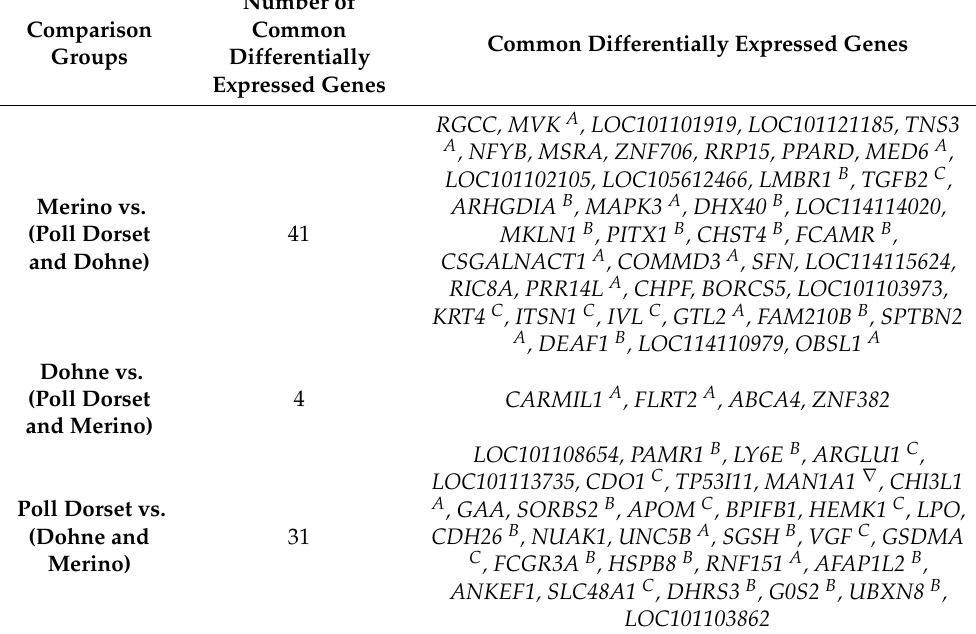
Table 5. List of common differentially expressed genes which were significantly expressed for each comparison group (seen in Figure 1); Merino, Dohne, and Poll Dorset rams. Number of Common Comparison Common Differentially Expressed Genes Differentially Groups Expressed Genes